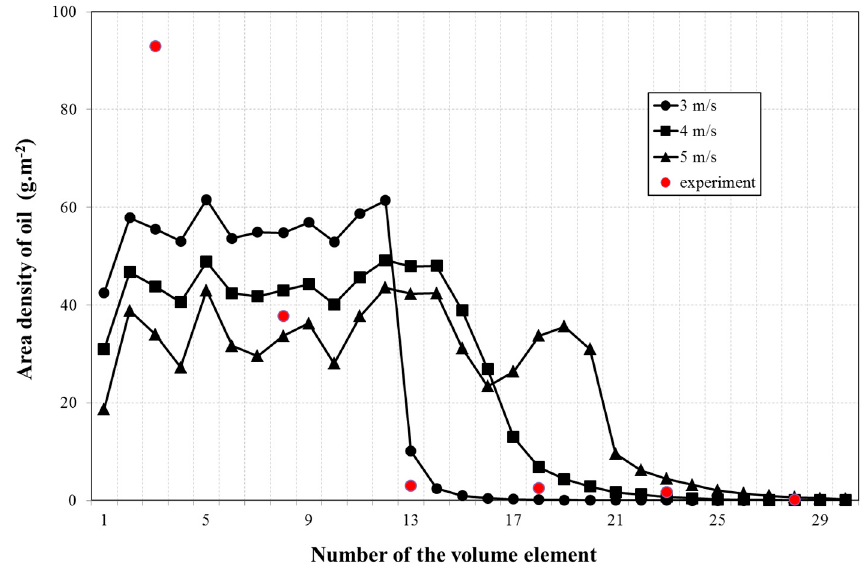
Figure 8. Plot of the areal density of oil at three different velocities compared to data measured on an inner pipe with a diameter of 15 mm.